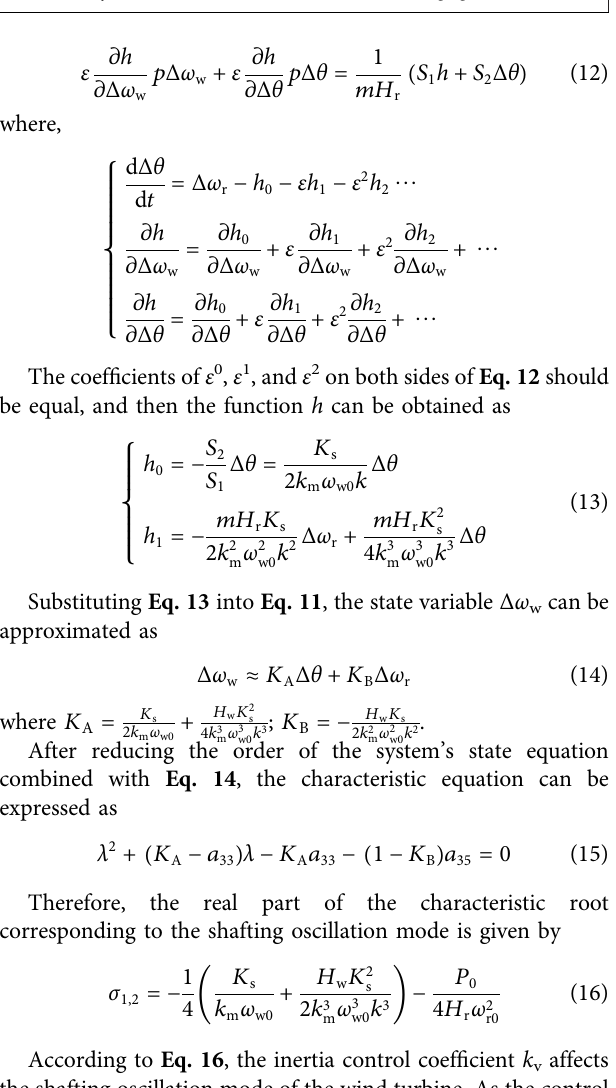
FIGURE 5 | Root locus of oscillation mode with k v